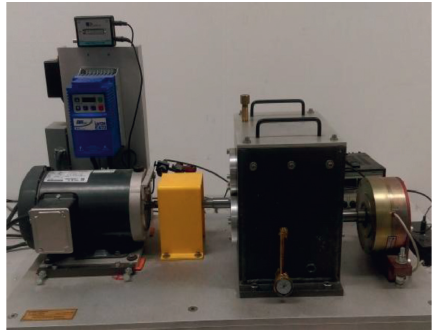
Figure 1: Gear box experimental platform.